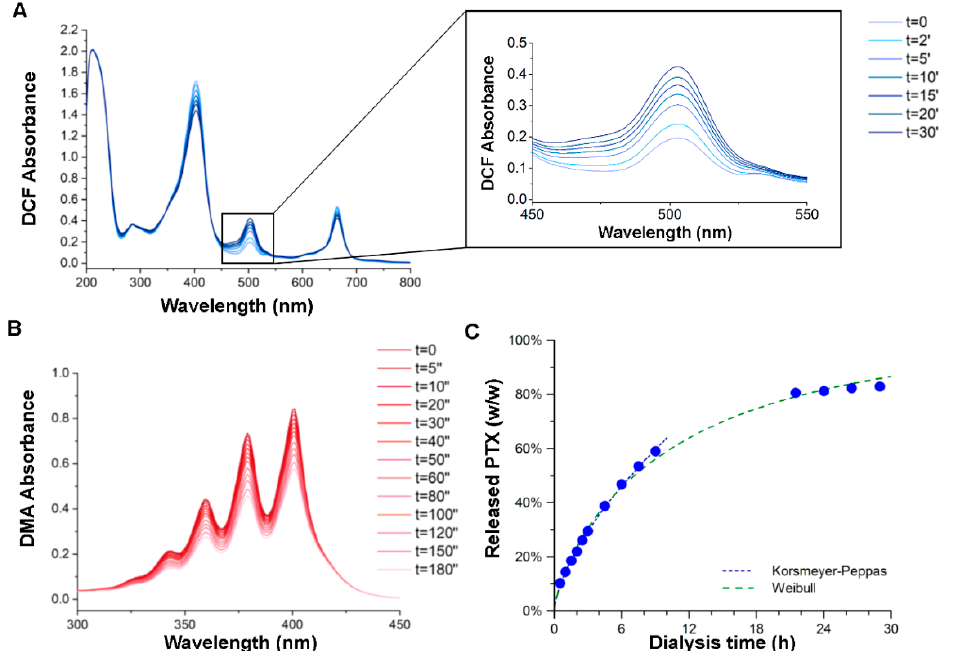
Figure 2. Chemical characterizations of PTX-Ce6@ker nanoformulation. ( A , B ) The graphs show the absorption spectra reflecting ROS and 1 O 2 production, respectively, measured at different irradiation times, expressed as minutes for ROS (‘) and seconds (‘’) for 1 O 2 . ( C ) Release kinetics of PTX from PTX-Ce6@ker nanoparticles, as determined by equilibrium dialysis at 37 ◦ C in (PBS, pH 7.4)/ethanol (75:25, v / v ) and HPLC-UV analysis. Korsmeyer–Peppas model: y = 0.1461 x 0.6406 (R 2 = 0.9962); Weibull model: y = 1 − e − 0.1621 x 0.7898 (R 2 =